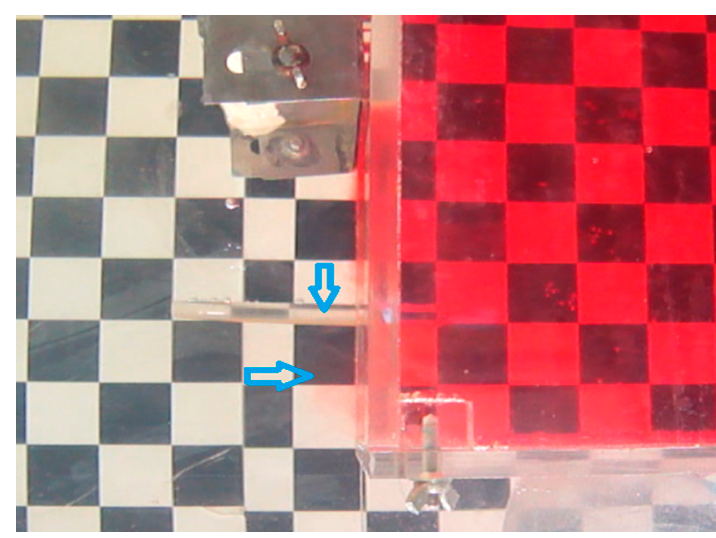
Figure 5. Insufficient exhaust flow rate.